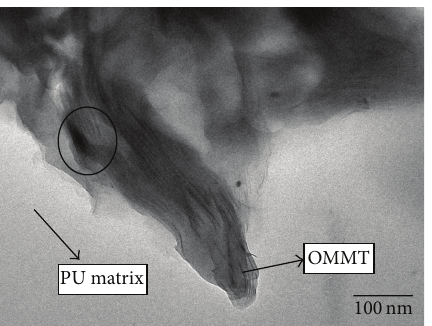
Figure 14: TEM image of PU nanocomposite foams with 5wt% OMMT.